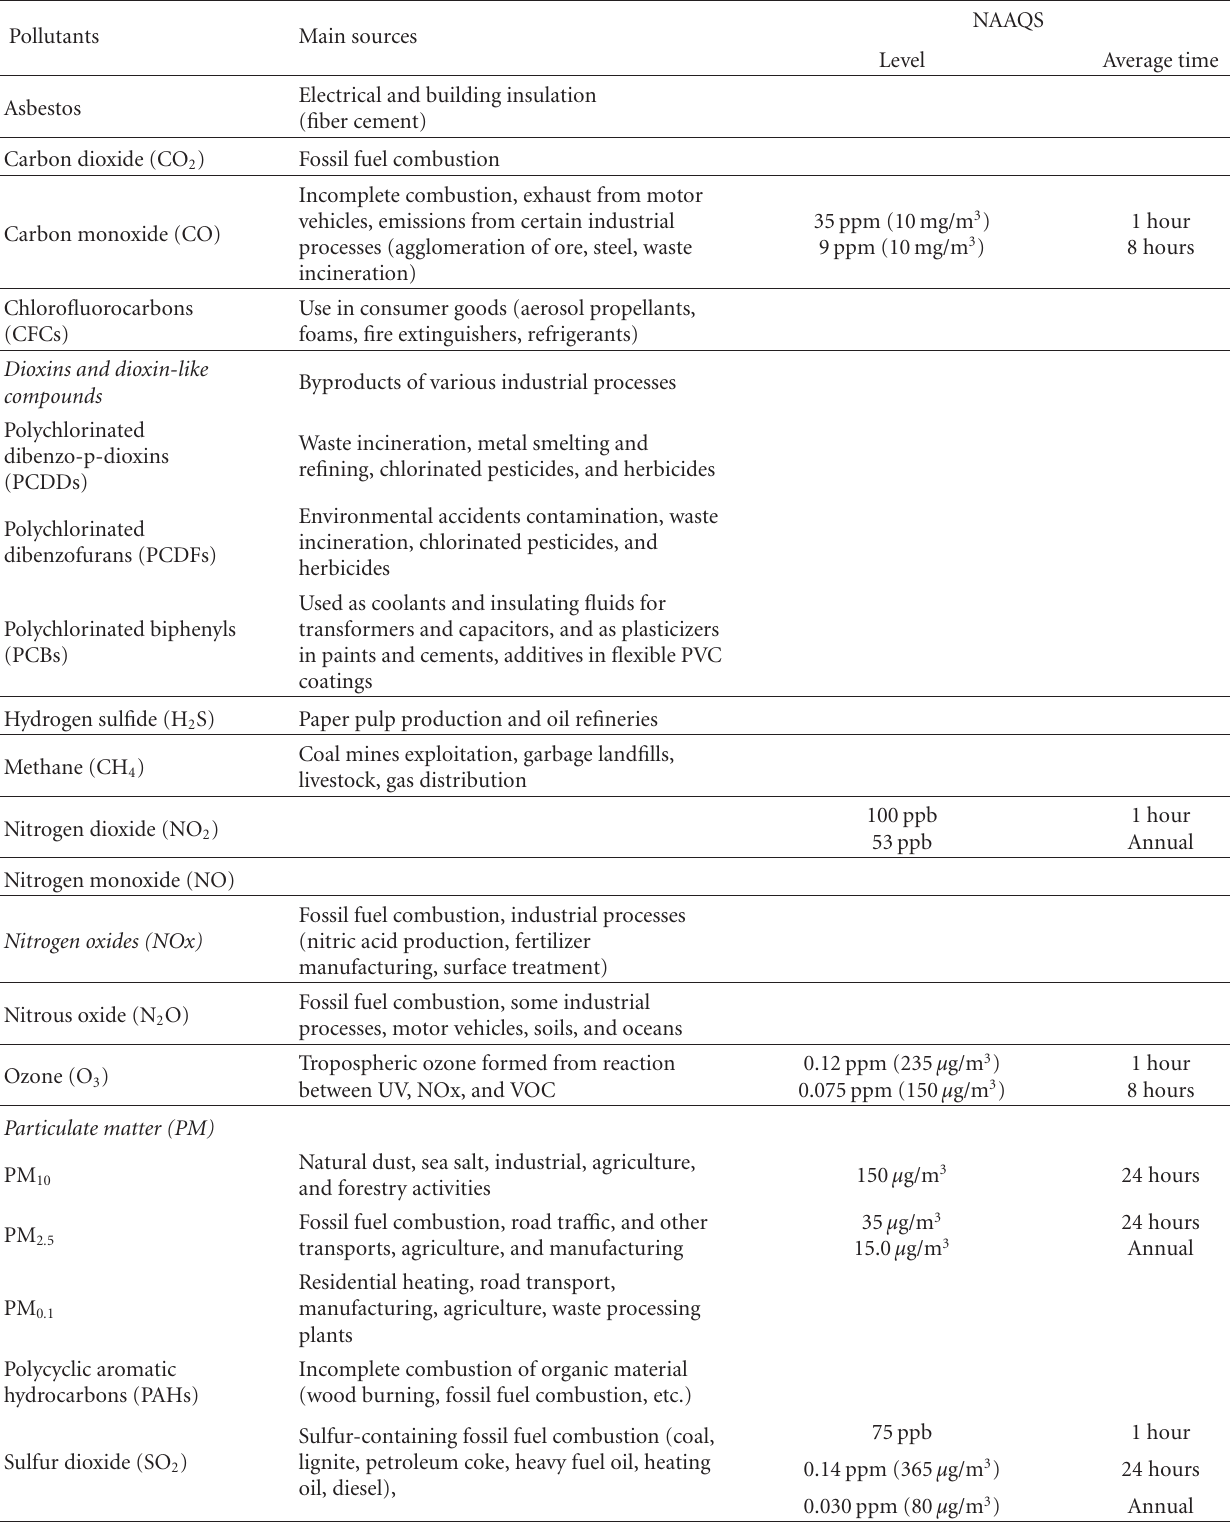
Table 1: Air pollutants. The National Ambient Air Quality Standards (NAAQSs) are set by the Environmental Protection Agency under authority of the Clean Air Act and define the maximum allowable concentrations of outdoor air pollutants in the USA. Units of NAAQS are parts per million (ppm) by volume, parts per billion (ppb-1 part in 1,000,000,000) by volume, milligrams per cubic meter of air (mg/m 3 ), and micrograms per cubic meter of air ( μ g/m 3 ). Average time refers to time for which the values of NAAQS should not be exceeded in the ambient air